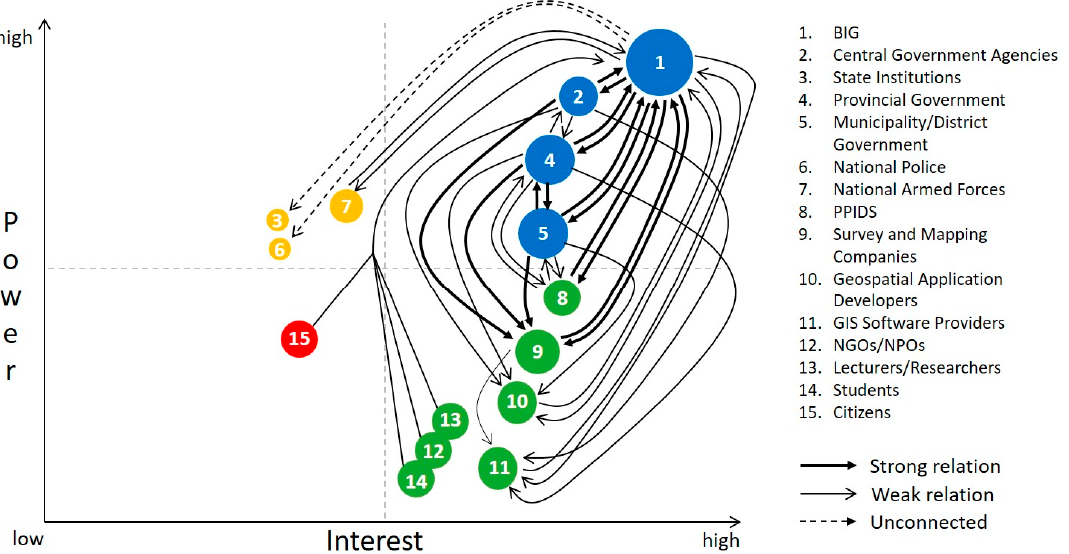
Figure 9. National spatial data infrastructure actor-linkage